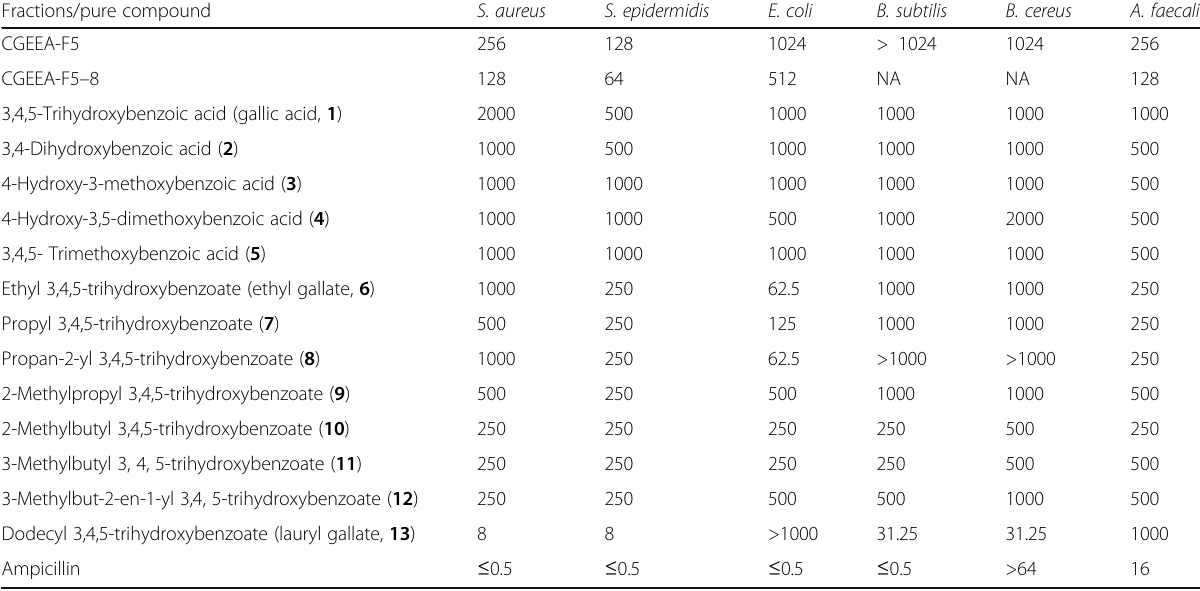
Table 1 The MIC ( μ g/ml) of CG sub-fractions, synthetic and commercially sourced gallate derivatives against a panel of six bacteria Fractions/pure